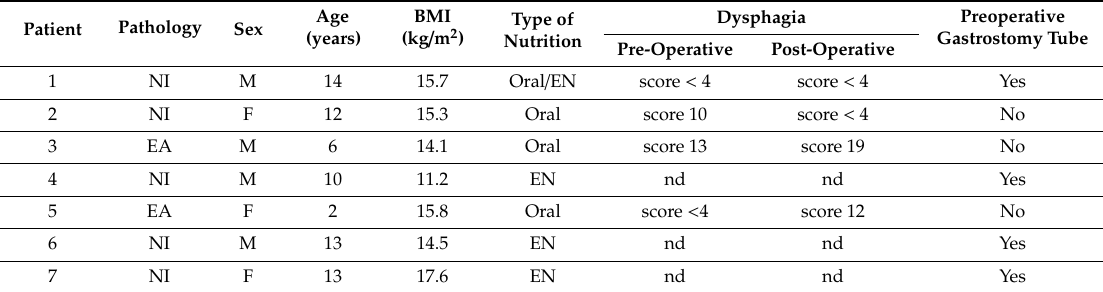
Table 1. Clinical features of the enrolled patients prior to antireflux